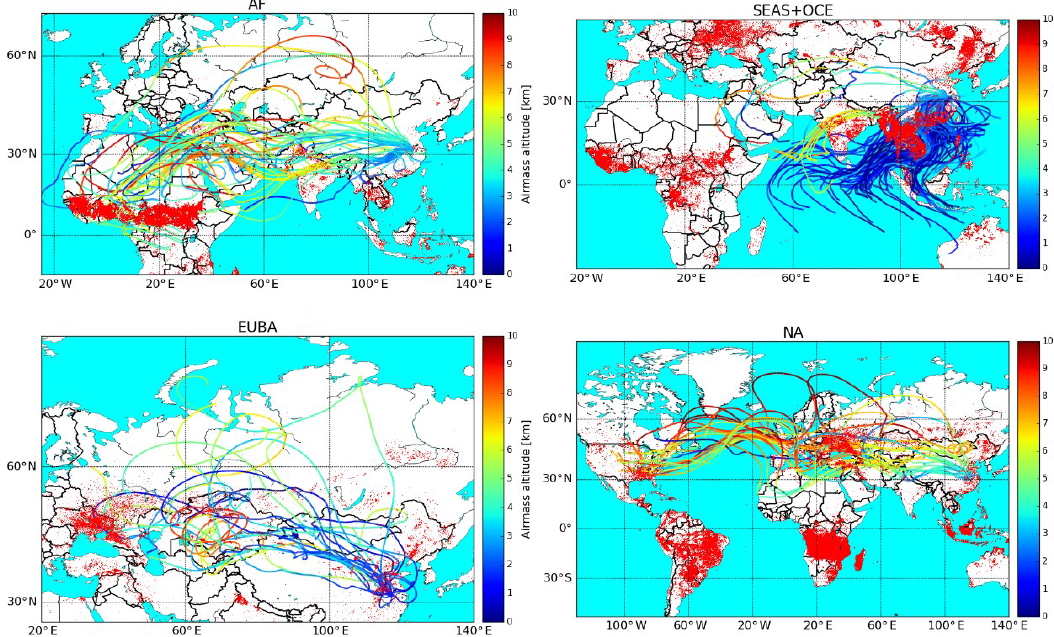
Figure 11. Travel trajectories of the plumes occurred in AF, SEAS & OCE, EUBA, and NA that reached Hefei (32 ◦ N) through long-range transport. Travel times are 13, 7, 10, and 14d, respectively. For clarity, only few trajectories are selected for demonstration. FIRMS fire numbers are shown with red dots for 13, 7, 10, and 14d prior to the arrival time, respectively.